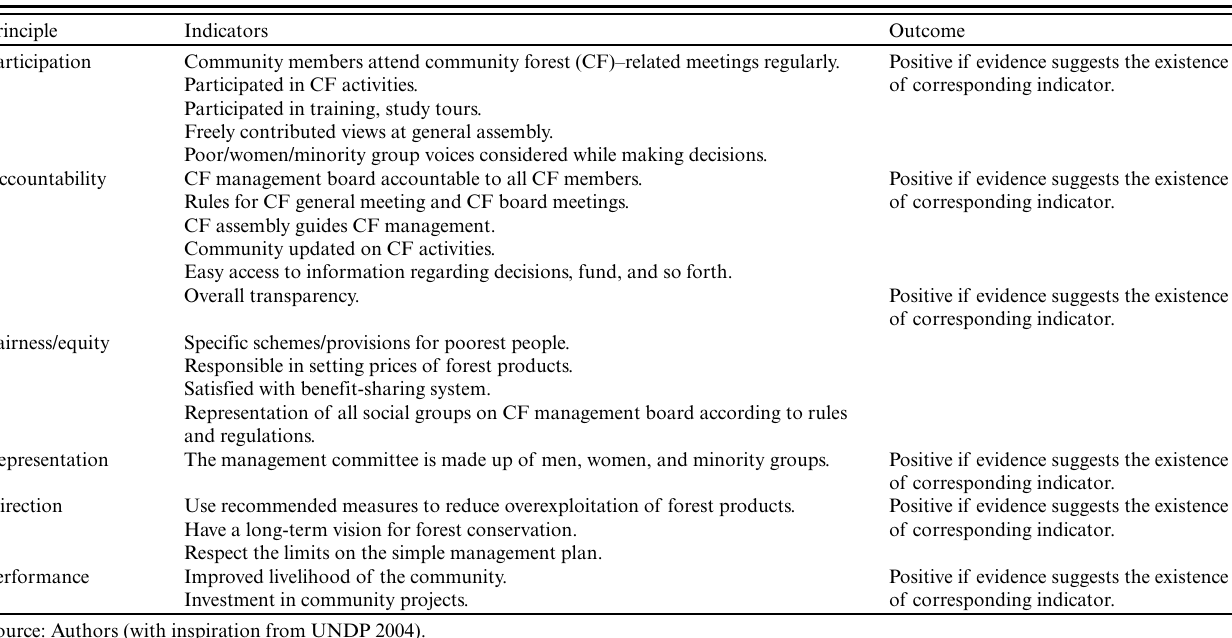
Table 2 . Governance principle and indicators used in the